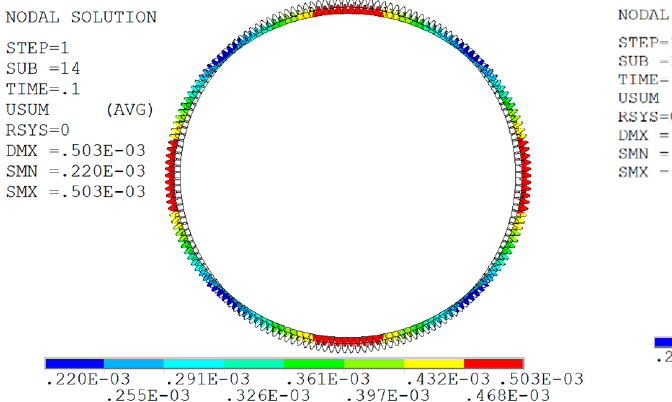
Figure 4. Simplified mesh model of the flexible wheel profile.